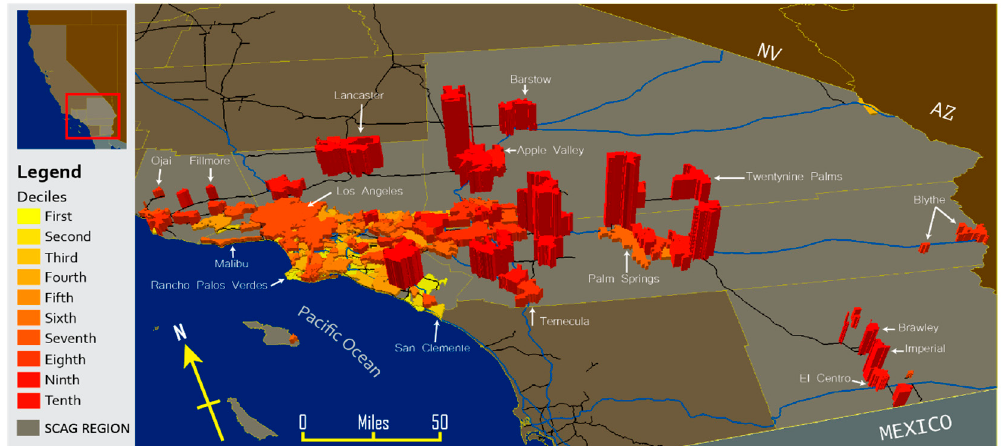
Figure 3. Map of the Los Angeles Region Cities by RHNA Growth Rates (RGR). The sample’s 185 cities were ranked from lowest to highest RGRs and then divided into deciles. This map illustrates that SCAG proportionally assigned high RGRs to the region’s outlying cities (e.g., Apple Valley, Barstow, Brawley, Imperial City, Lancaster, and Twentynine Palms). By contrast, SCAG proportionally assigned low RGRs to coastal cities like Malibu, Rancho Palos Verdes, and San Clemente. Note that the extrusion heights are not to scale. Source. SCAG.